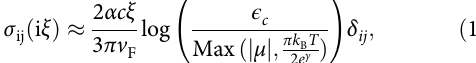
Fig. 5 Quantum Casimir energy for Weyl semimetals. The Casimir energy scaled by E y-direction as a function of: a distance for different values of cone tilting and chemical potential ( ϵ c = 5 eV, E b = 1 eV, c ∕ v F = 300). The vertical axis of the inset is in log scale for better visibility; b cutoff energy scaled by E b for different separations ( ϵ c = 5 eV, Ψ = 0, c ∕ v F = 300, μ = 0); ( c ) tilting for different separations and chemical potentials ( ϵ c = 5 eV, E b = 1 eV, c ∕ v F = 300, μ = 0); d chemical potential for different titling and separations ( ϵ c = 5 eV, E b = 1 eV, c ∕ v F = 300); e distance for different values of the Fermi velocity ( ϵ c = 5 eV, E b = 1 eV, μ = 0, Ψ = 0.5). In all calculations Γ /E b = 10 −